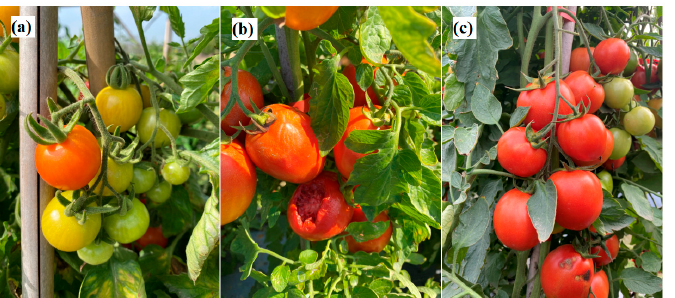
Figure 5. Illustrative images of tomatoes in three states: ( a ) ripe, ( b ) immature, and ( c ) damaged.